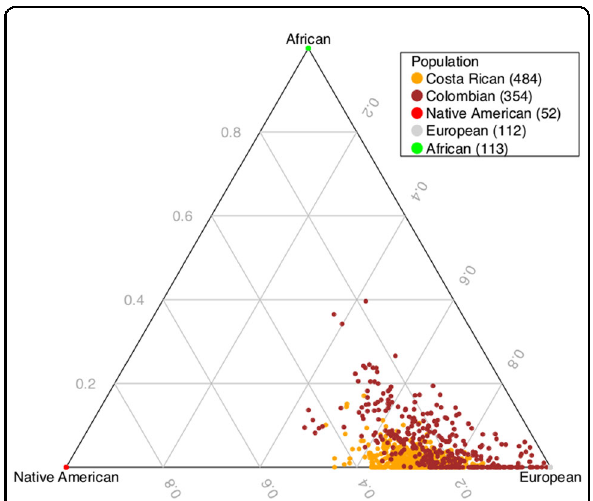
Fig. 1 A de Finetti diagram showing global estimates of admixture proportions among African, European, and Native American ancestries in the CO/CR pedigrees. The global estimates were calculated using microarray data with ADMIXTURE